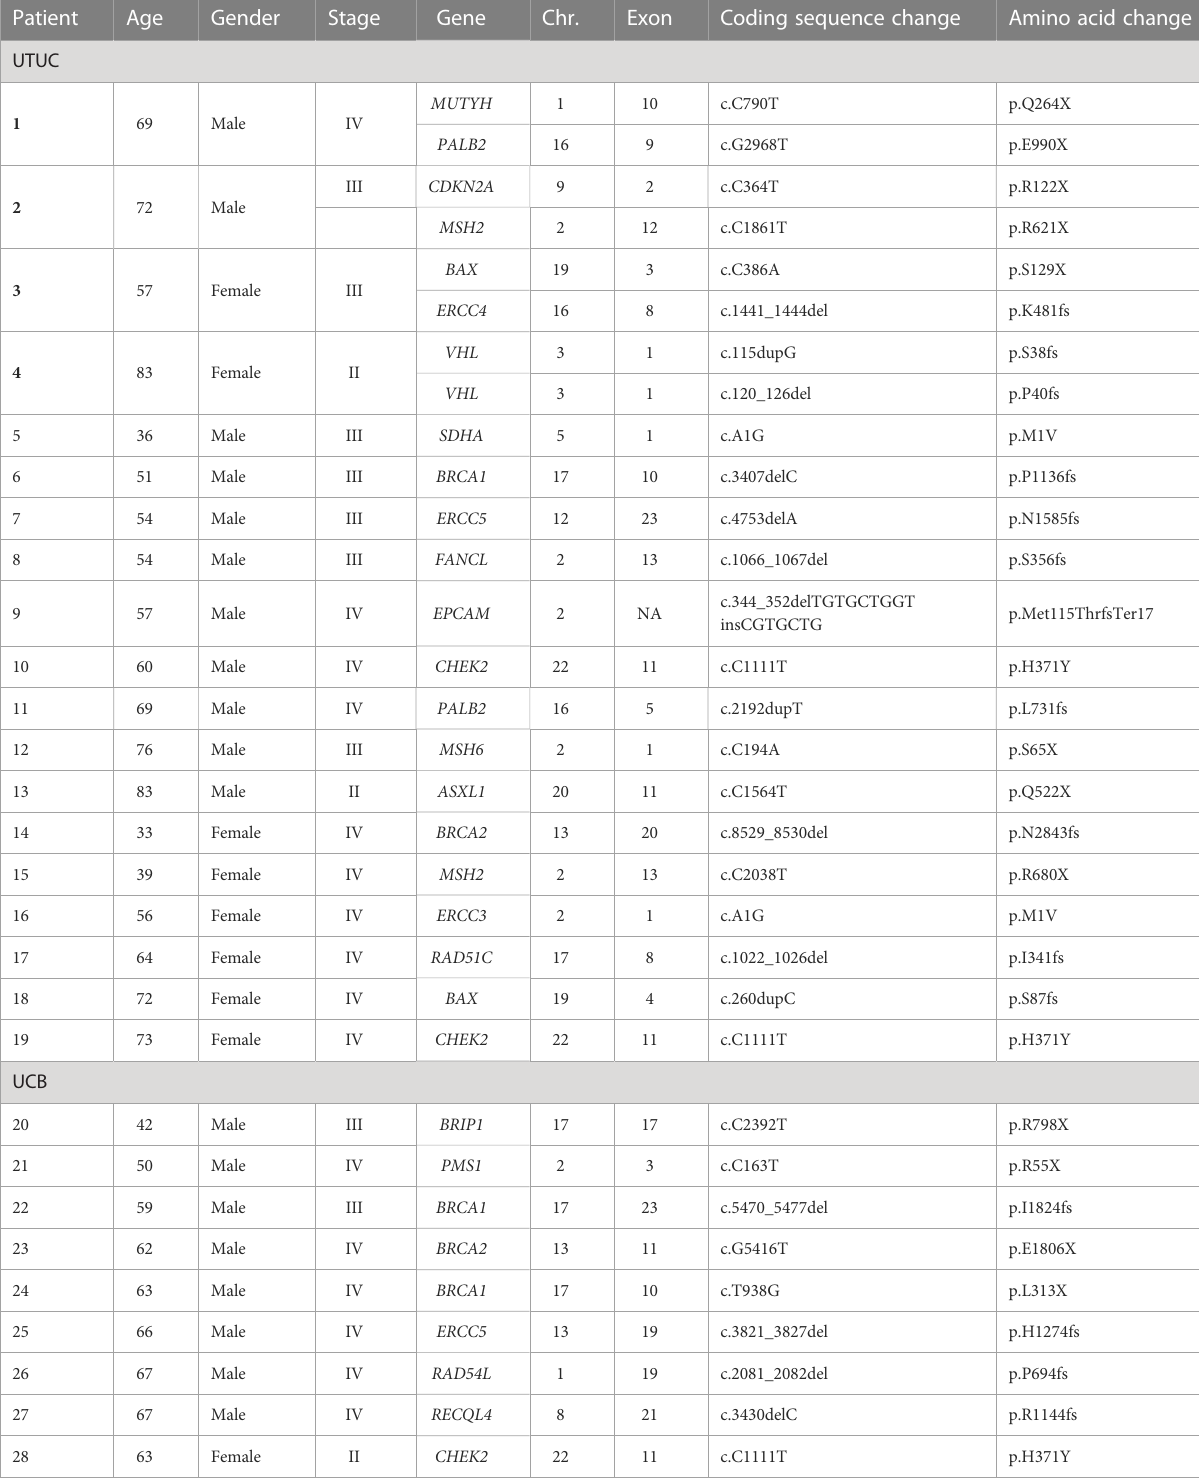
TABLE 2 The detail information of 32 germline P/PL variants in the Chinese